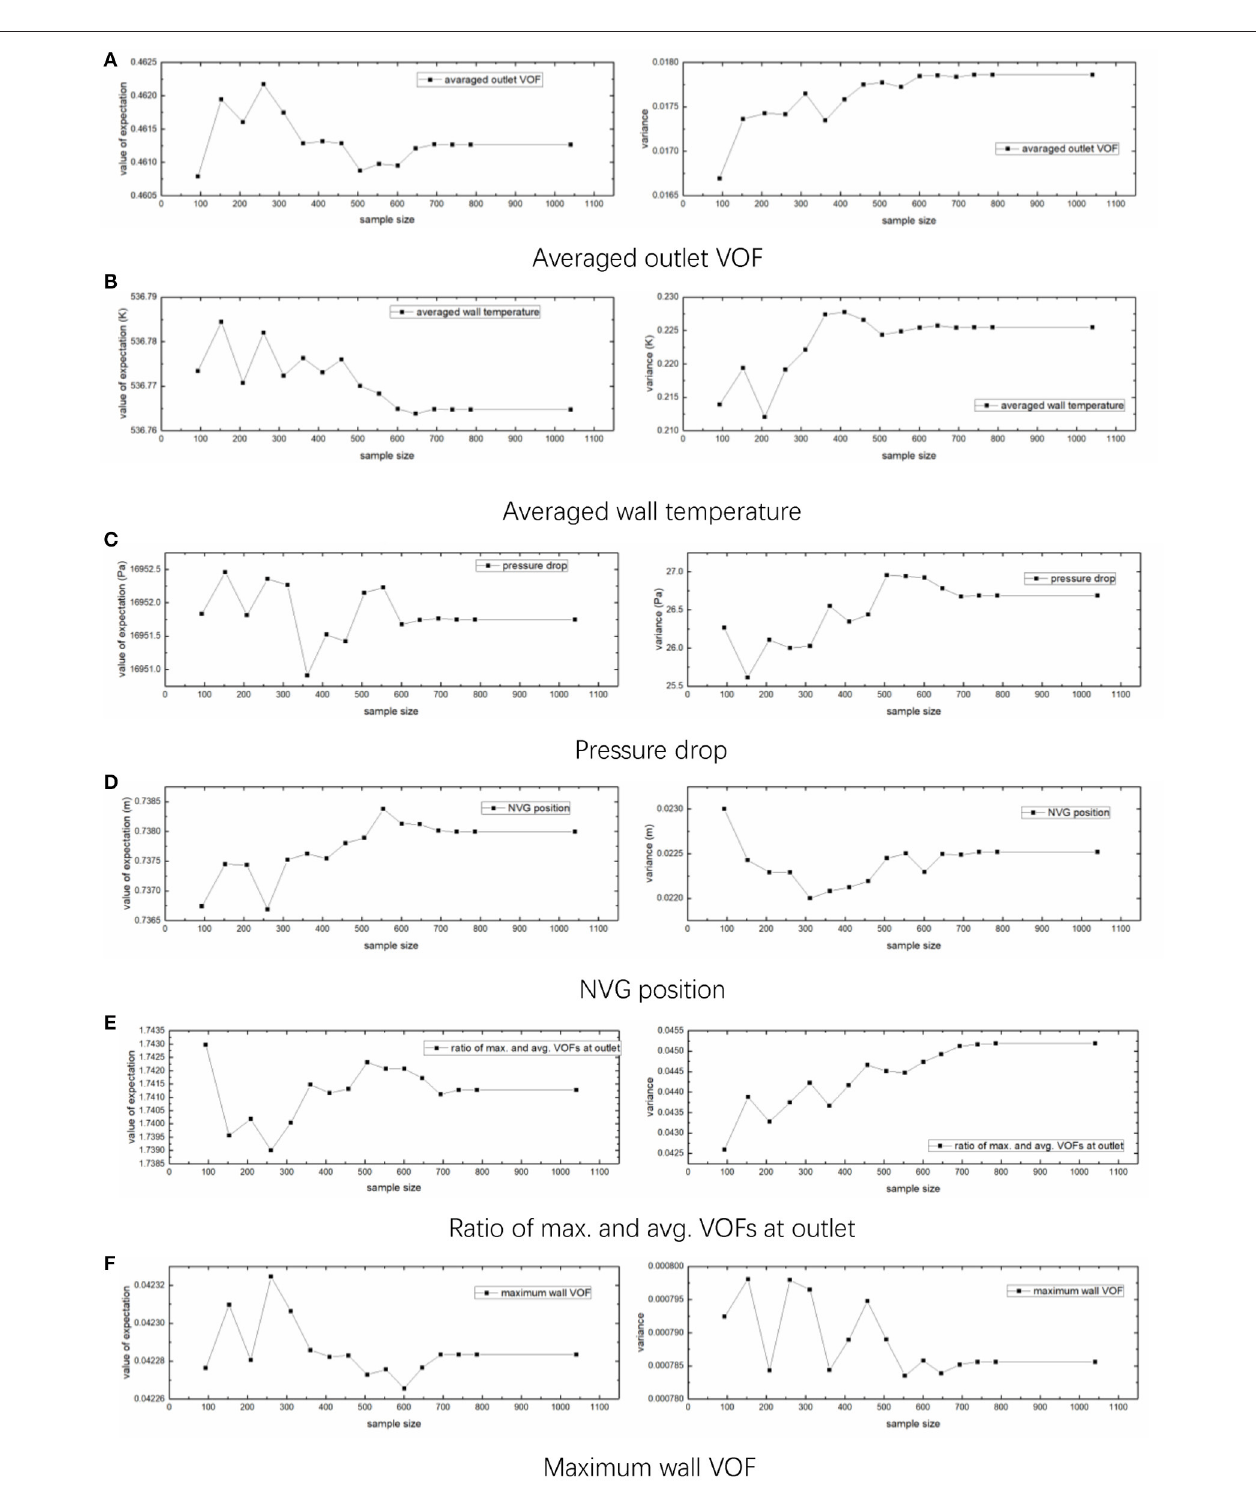
FIGURE 3 | Convergence curve for expectation and standard deviation. (A) Averaged outlet VOF. (B) Averaged wall temperature. (C) Pressure drop. (D) NVG position. (E) Ratio of max. and avg. VOFs at outlet. (F) Maximum wall VOF.